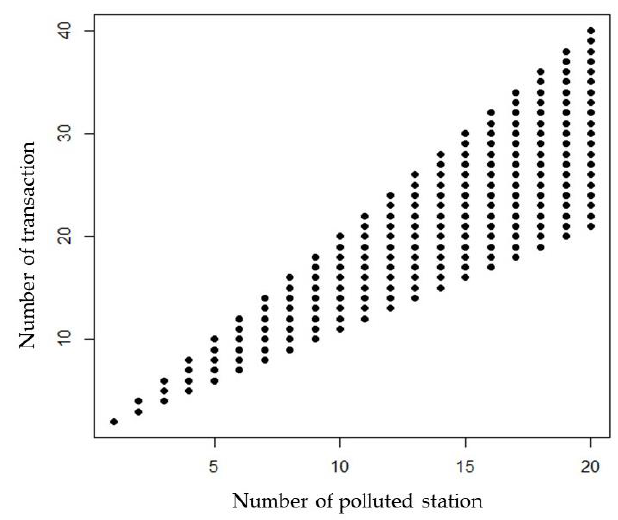
Figure 11. Big O notation analysis of the relationship in the number of Blockchain transactions and the number of polluted stations.